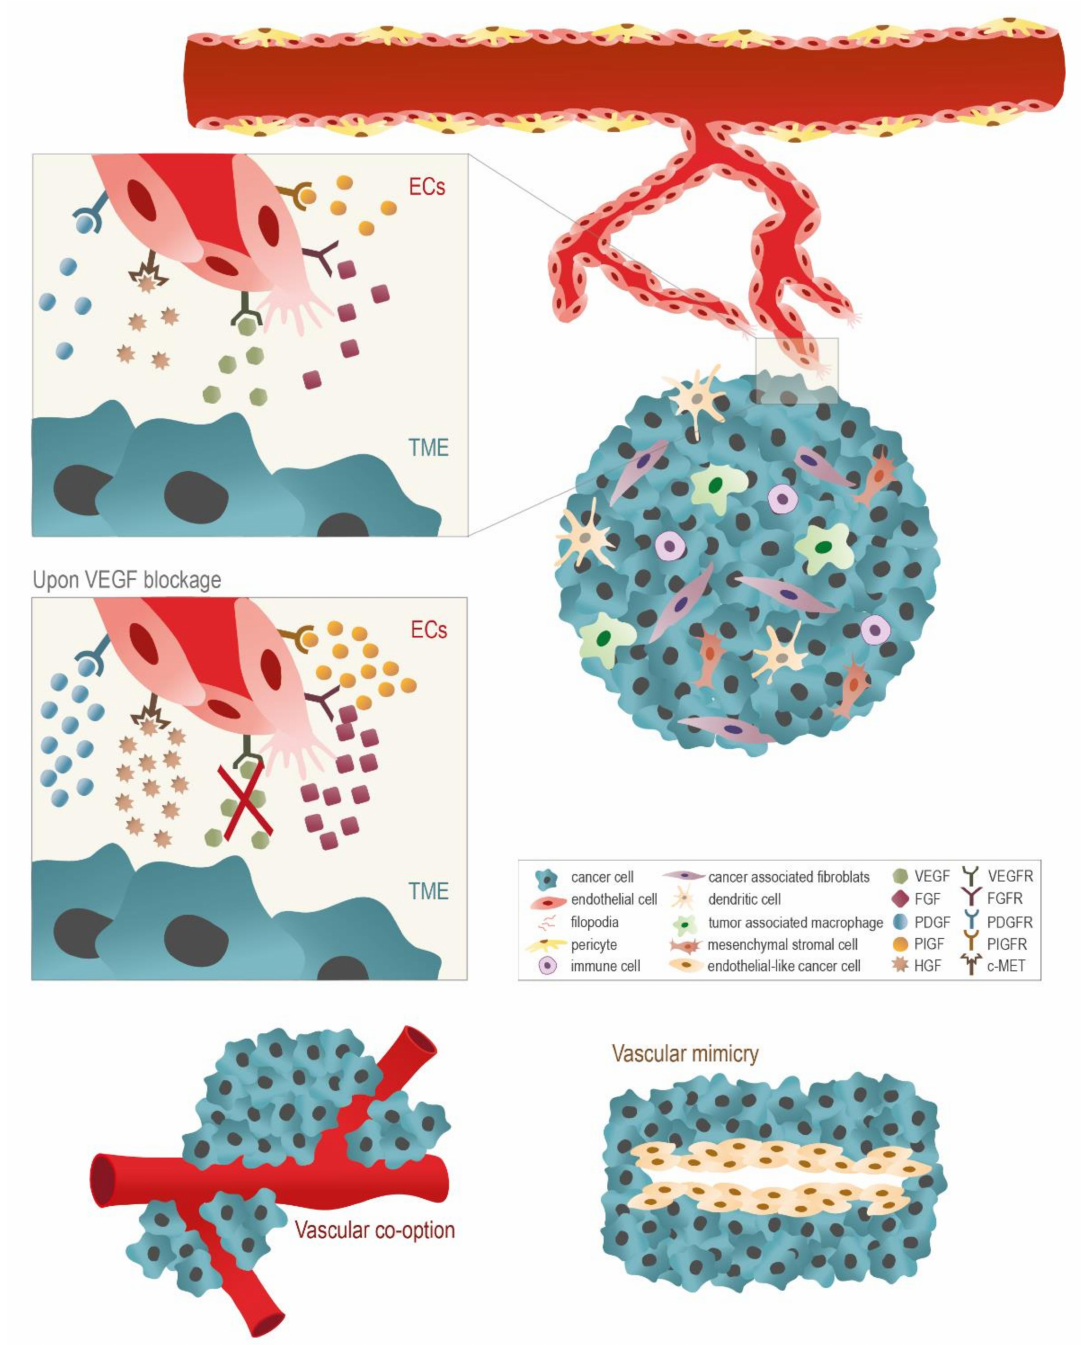
Figure 1. Pro-angiogenic factors released by cancer cells and tumor microenvironment (TME) are essential for neo- angiogenesis promotion, tumor growth, vascular co-option or vascular mimicry. Neo-angiogenesis is stimulated by the release of pro-angiogenic factors by cancer cells or by other cells in the tumor microenvironment (TME), as macrophages, stromal cells, and fibroblast. Among the positive regulators, vascular endothelial growth factor (VEGF) is the most well- studied, and it is almost ubiquitously present at angiogenesis sites. Once it binds to its tyrosine kinases receptors (VEGFRs), they become activated and form homo- or heterodimers, triggering intracellular signaling cascades to stimulate ECs’ proliferation, migration, differentiation, tube formation, and permeability control. Besides VEGF, other pro-angiogenic factors as fibroblast growth factor (FGF), platelet-derived growth factor (PDGF), placental growth factor (PIGF), and hepatocyte growth factor (HGF) are essential for endothelial tip cell activation (endothelial cell (EC)) that respond and guide EC migration in the direction of a pro-angiogenic stimulus, thereby promoting neo-angiogenesis). Moreover, a key process during EC migration is the formation of filopodia (actin-rich cellular protrusions) in tip cells, that will guide